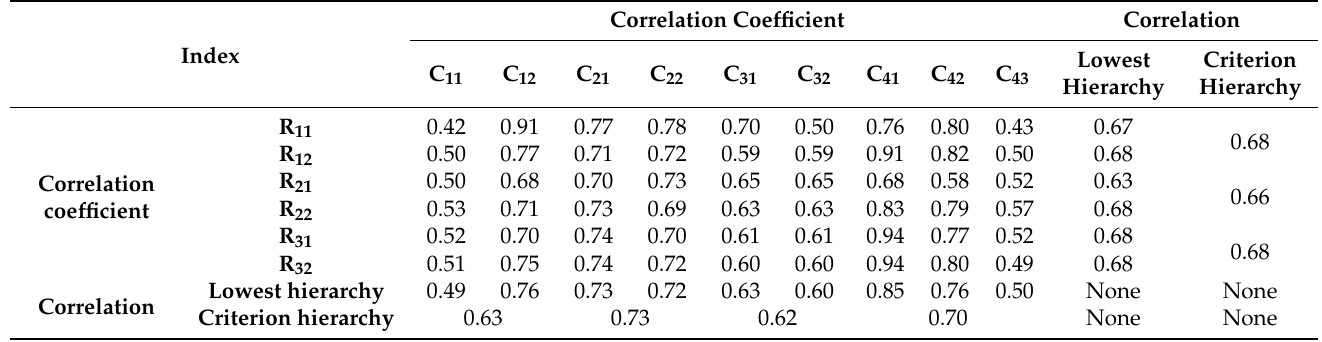
Table 2. Correlation matrix between RT and